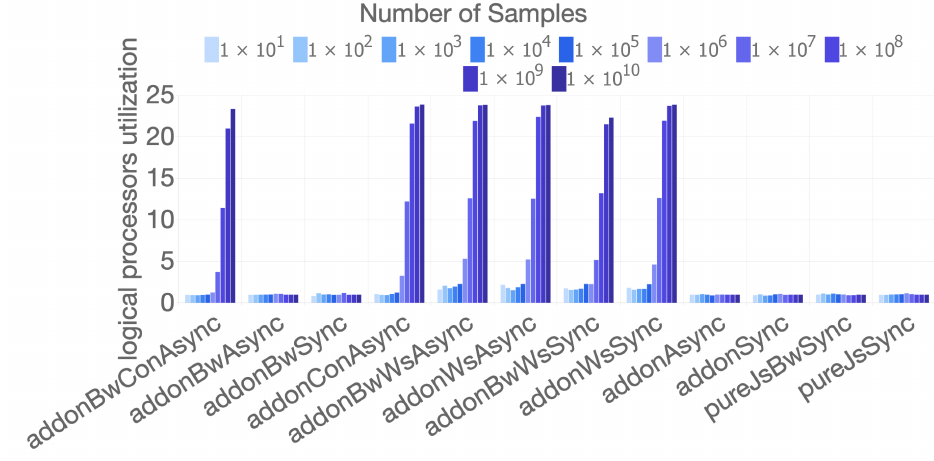
Figure 5. Average CPU utilization in Node.js.